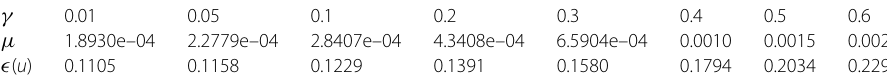
Table 4 At t = 0: α = 1.5, θ = 0, s = 2, ε = 0.01, the relative errors for various γ γ